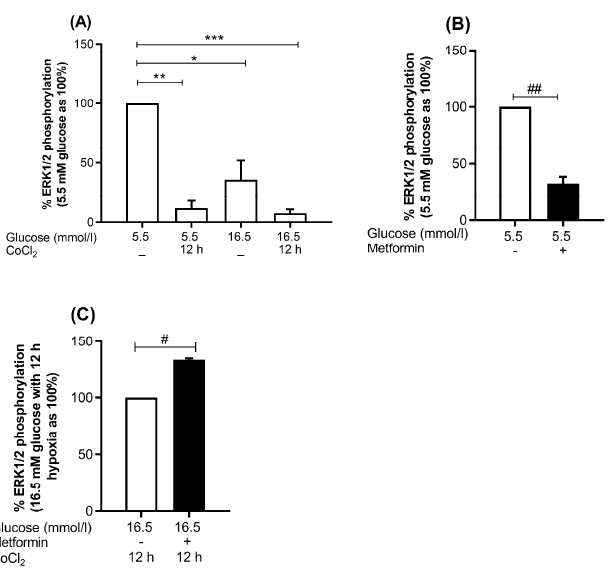
Figure 5. Effect of metformin on the activity of MAPK pathway. HUVEC were treated with euglycemia or hyperglycemia in the presence or absence of metformin for 48 h, and parallel cultures were exposed to CoCl 2 for 12 h. ( A ) Represents % of ERK1/2 phosphorylation ( B ) Effect of metformin on euglycemia, and ( C ) hyperglycemia combined with 12 h chemical hypoxia CoCl 2 . Percentage of phosphorylation indicates relative intensity of phospho-protein/total protein. The variation in protein expression levels was assessed by flow cytometry on three independent biological replicates. Results are presented as mean ± SEM and were analyzed using paired t -test. * p < 0.05, ** p < 0.01, *** p < 0.002 compared to the control. # p < 0.05, ## p < 0.01 compared pairwise, i.e., metformin-treated condition versus untreated condition.